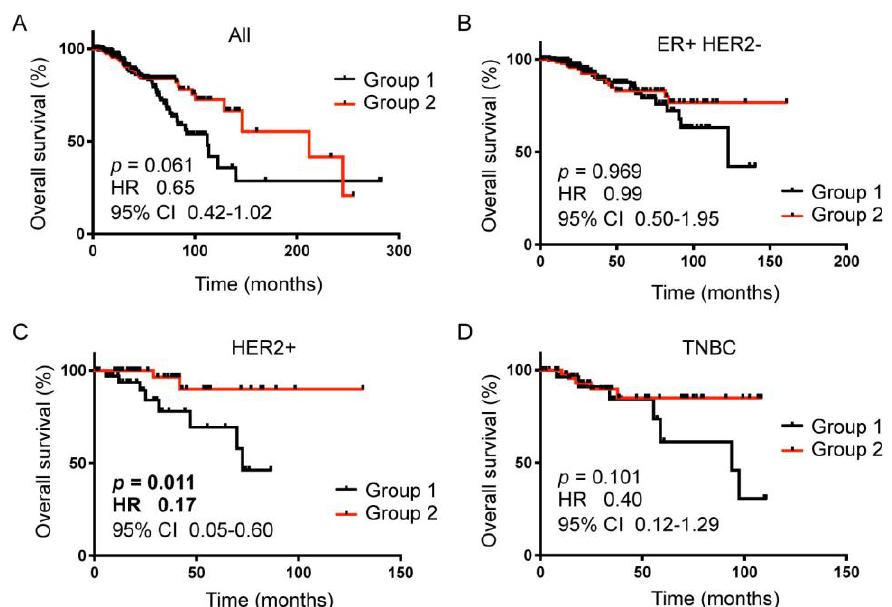
Figure 4. Kaplan-Meier survival analyses of the TCGA breast cancer patient data using PAGES-HBC Group 1 vs Group 2 compositions. ( A ), All breast cancer patients, ( B ), ER + HER2 − breast cancer patients, ( C ), HER2 + breast cancer patients, ( D ), Triple-negative breast cancer patients. Black line, Group 1 patients; red line, Group 2 patients; Kaplan-Meier analysis was done using Prism Graphad software; p values and hazard ratios were determined using Log-rank (Mantel-Cox)